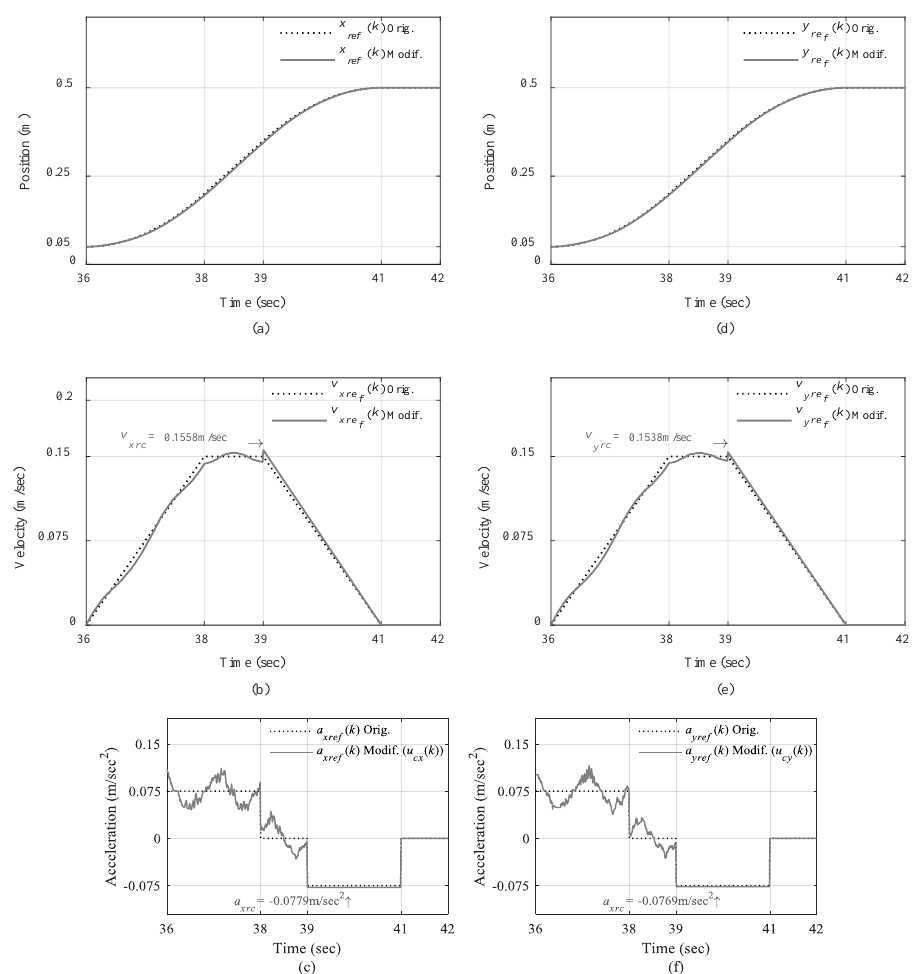
Figure 11. Load swing in X and Y directions for slow trajectory in ( a ) 1st; ( b ) 2nd; ( c ) 3rd Scenarios and for fast trajectory in ( d ) 1st; ( e ) 2nd, and ( f ) 3rd Scenarios.